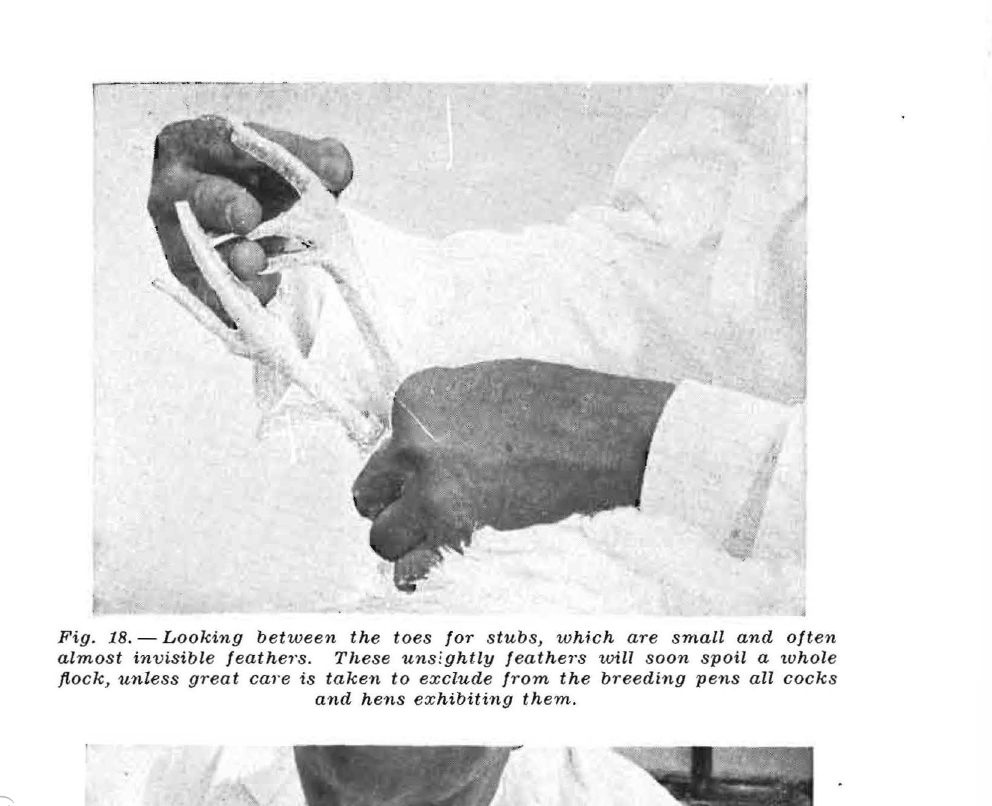
Fig. 18. - Looking between the toes tor stubs, which are small and otten almost invisible teathm·s. These 1tns:ghtly t eathe,.s will soon spoil a whole flock, 1tnless great COl'e is taken to exclude trom the breeding pens all cocks and hens exhibiting them.